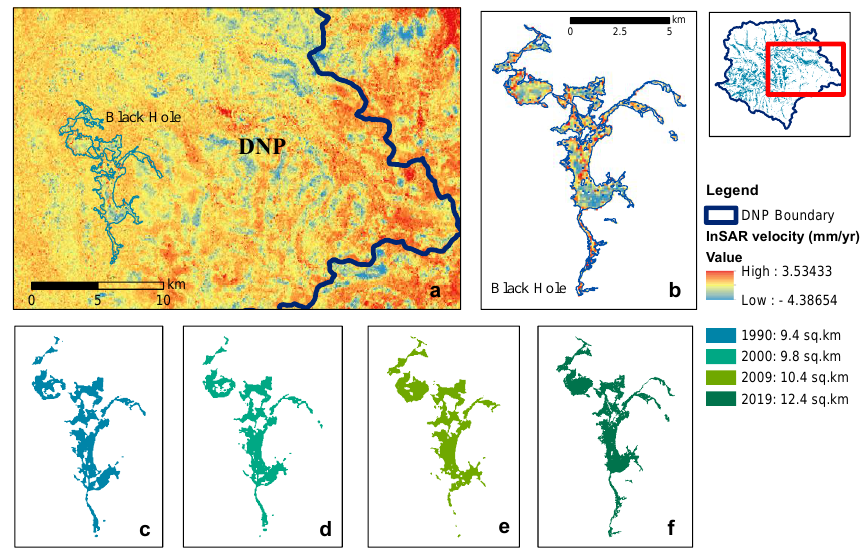
Figure 9. ( a ) Map of the Vertical velocities values, and in ( b ) on the Black Hole; ( c – f ) extension of the wetland from optical data in the range 1990–2019. The red box of the high-right map of the DNP represents the area in ( a ).